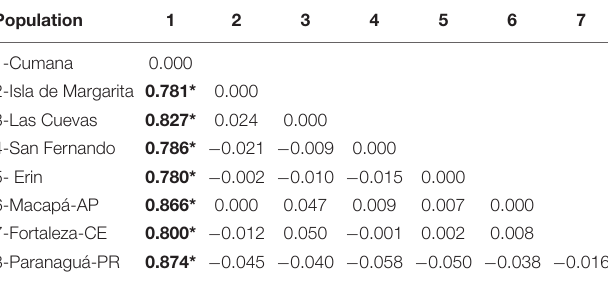
TABLE 1 | Genetic diversity and the results of the neutrality tests for the different Scomberomorus brasiliensis localities, based on two mitochondrial genes. Locus/Population